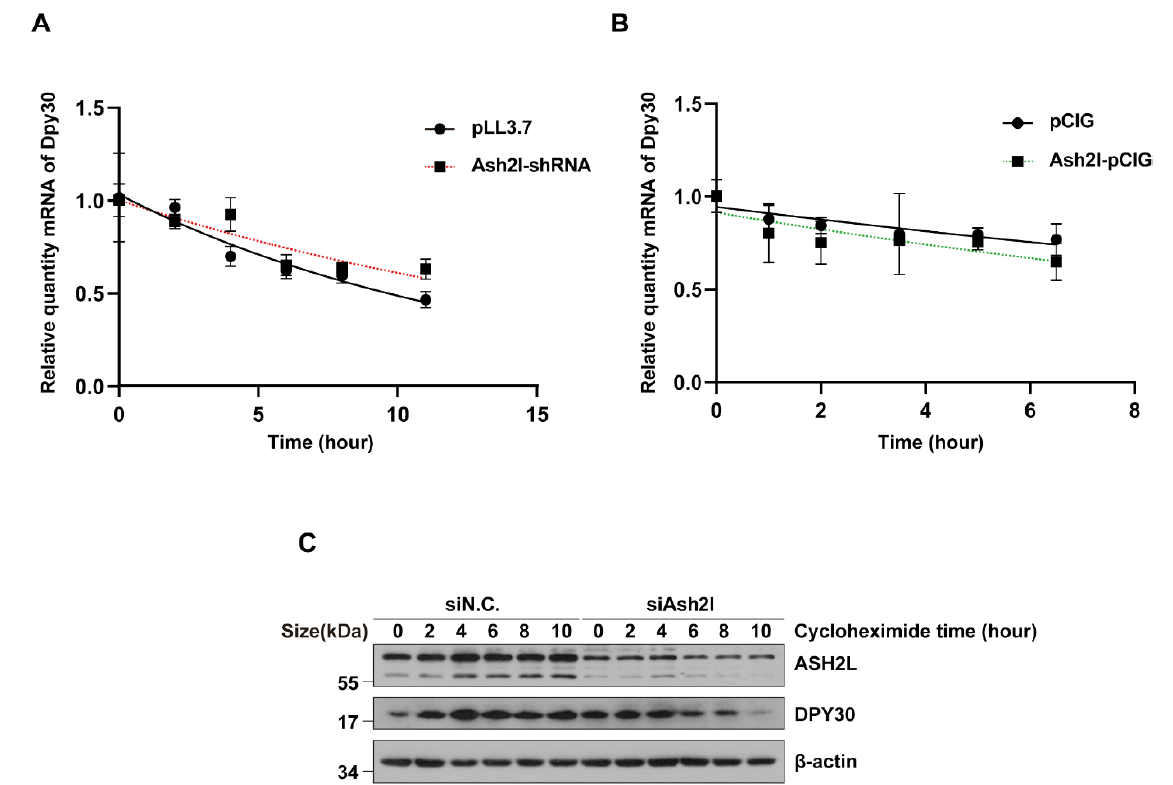
Figure 3. ASH2L is necessary for the stability of DPY30. ( A , B ) mRNA stability assays to detect the relative quantity of Dpy30 mRNA by RT-qPCR after knockdown and overexpression of Ash2l followed with actinomycin D (10 µ g/mL) treatment. Relative quantity is normalized by GAPDH at each timepoint. The experiment was repeated three times, and the standard deviation is shown. The t -test at each timepoint indicates no significant difference. ( C ) HEK293T cells were transfected with Ash2l-shRNAs for 36 h and treated with cycloheximide (50 µ g/mL) for the duration shown in hours. The expression levels of ASH2L and DPY30 were tested by Western blotting. The experiment was biologically repeated three times.